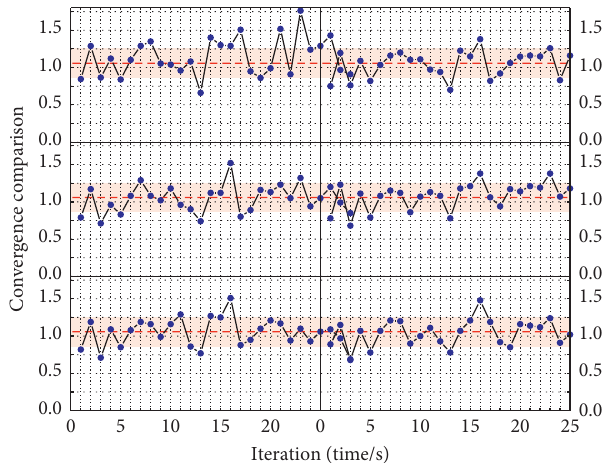
Figure 8: Comparison of convergence under different training sets.